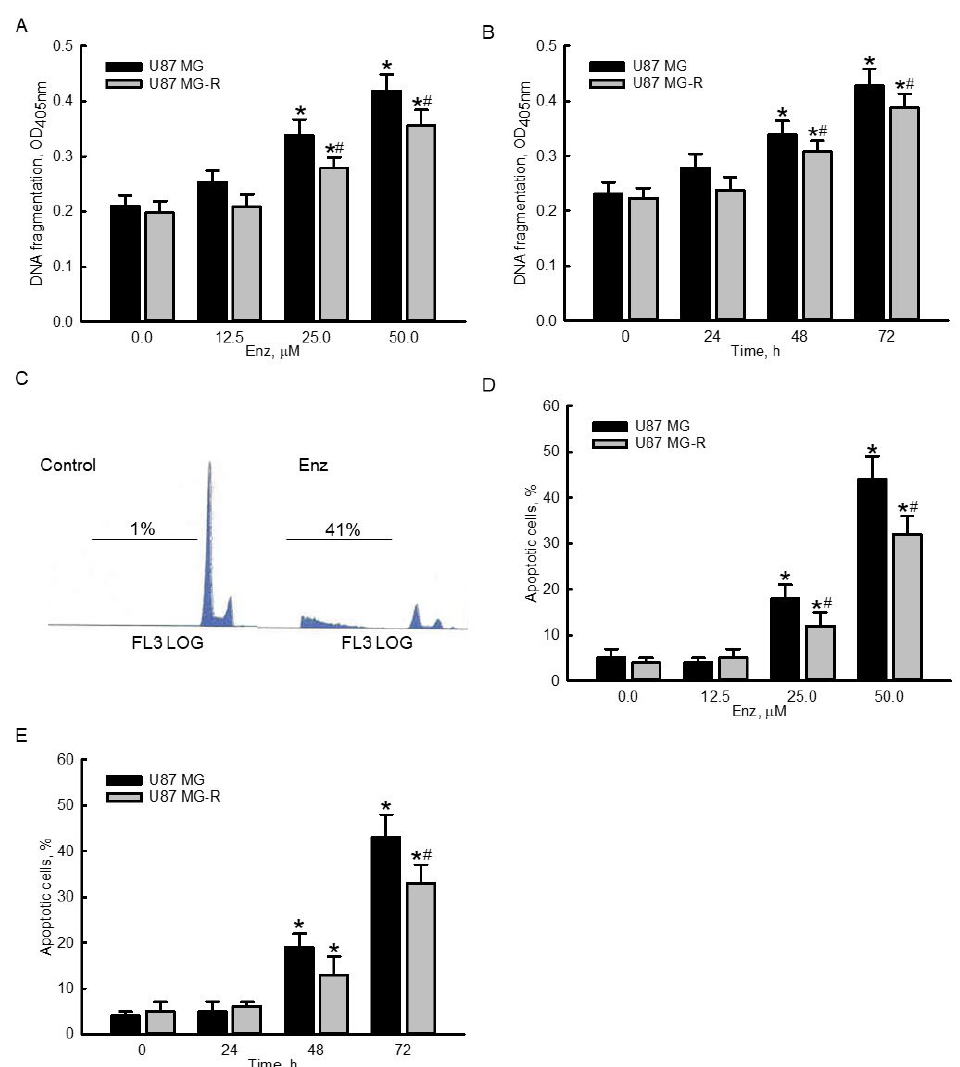
Figure 3. Enzalutamide (Enz) induced DNA fragmenation and cell apoptosis in human temozolomide (TMZ)-sensitive U87 MG and TMZ-resistant U87 MG-R glioblastoma cells. Human U87 MG and U87 MG-R glioblastoma cells were treated with 12.5, 25, and 50 µ M Enz for 72 h ( A , D ) or with 50 µ M enzalutamide for 24, 48, and 72 h ( B , E ). DNA fragmentation was determined using an ELISA method ( A , B ). Apoptotic cells were quantified using flow cytometry ( C – E ). Representative histograms of FACS analyses in human U87 MG cells are shown ( C ). Each value represents the mean ± SEM for n = 6. The symbols * and # respectively indicate that the values significantly ( p < 0.05) differed from the control and U87 MG groups.